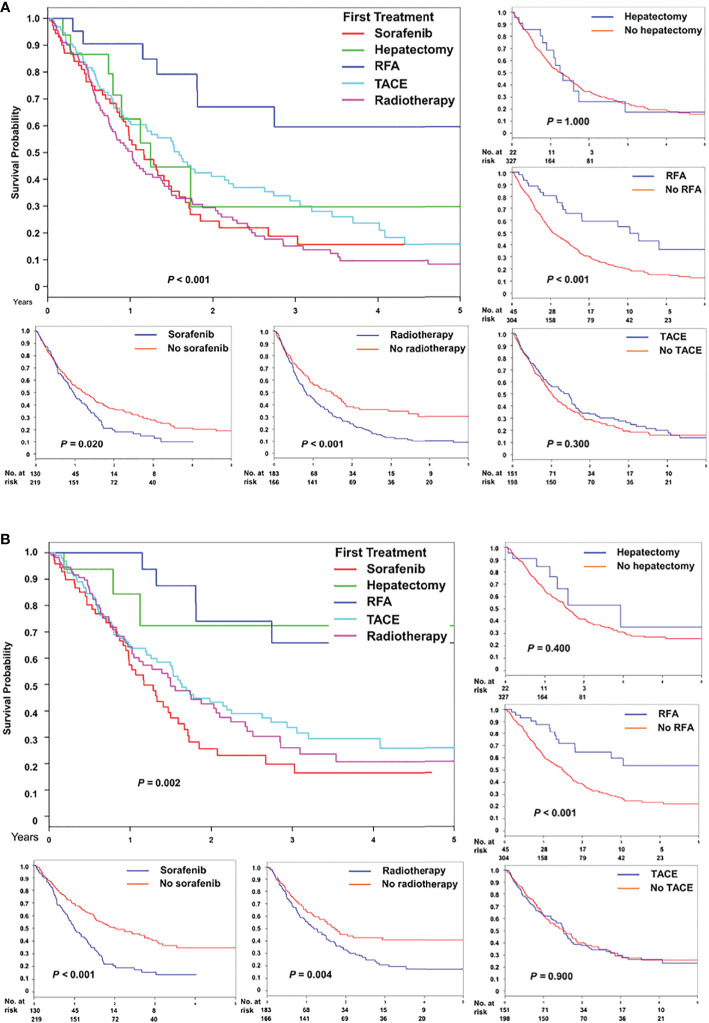
Comparison of (A) overall and (B) HCC-specific survival after treatment for recurrence, stratified based on five initial modalities, namely sorafenib, hepatectomy, radiofrequency ablation, transarterial chemoembolization, and radiotherapy, and individual modality.